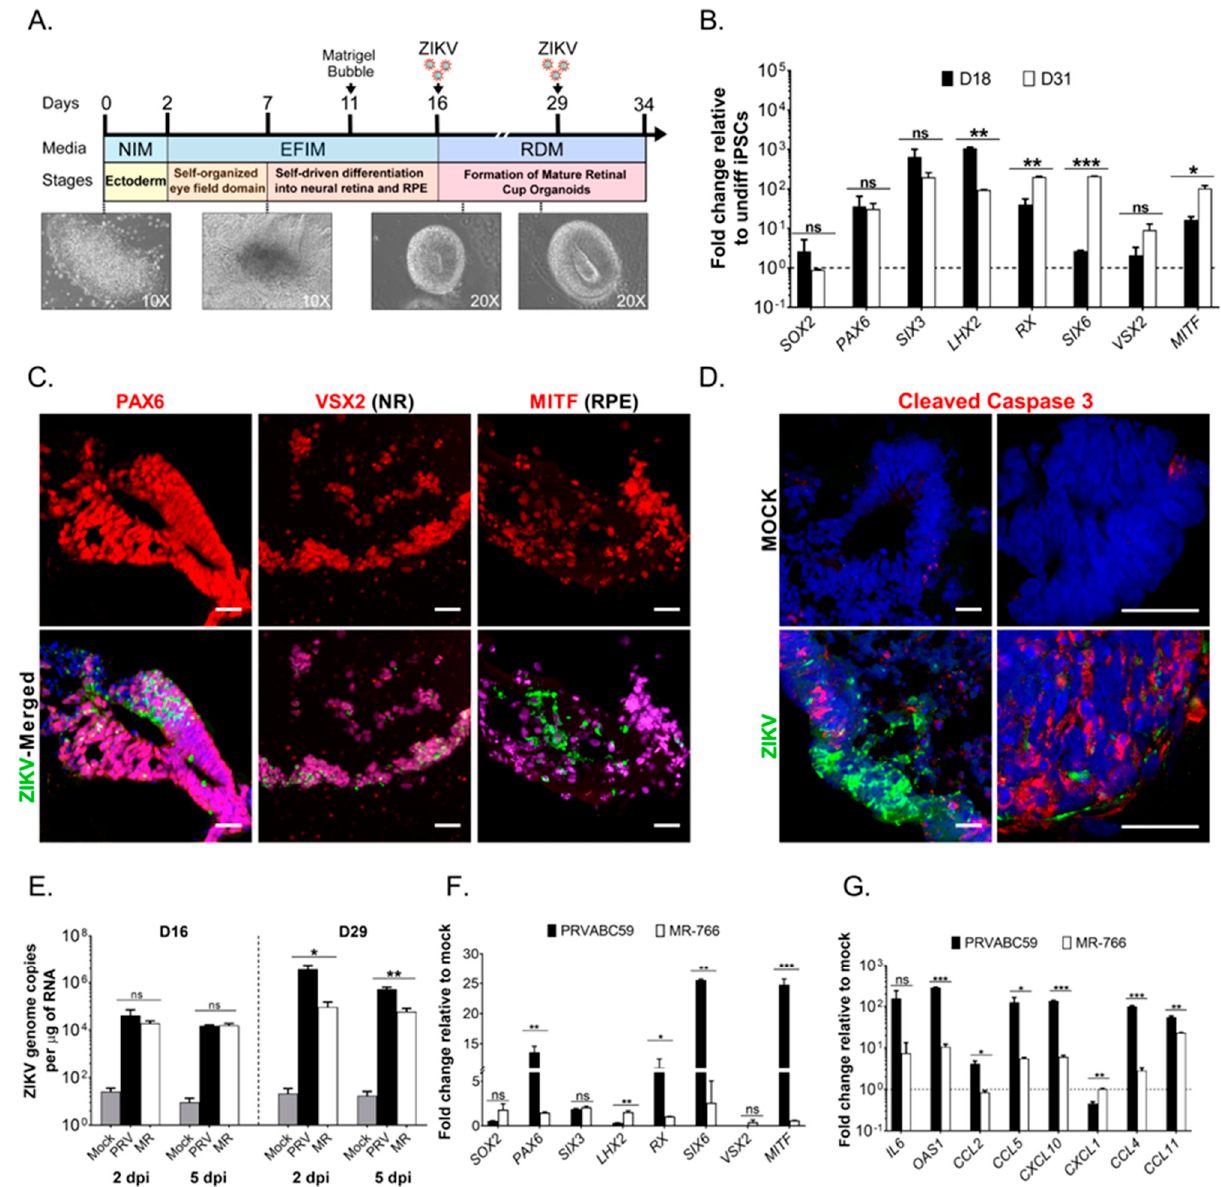
Figure 6. ZIKV infects the neural retina and RPE of human iPSC-derived Retinal Organoids. ( A ) Schematic timeline showing key differentiation stages of retinal organoids with stage-specific bright-field images. Organoids were infected with ZIKV on days 16 or 29 post-differentiation. ( B ) RT-qPCR analysis of early eye- and retinal-specific markers. Graph shows the fold change of each transcription factor relative to undifferentiated hiPSCs at days 18 and 31 post-differentiation. ( C ) Immunofluorescence images of mature retinal organoids infected on day 29 post-differentiation with ZIKV PRVABC59. Images show that PAX6, MITF (RPE), and VSX2 (neural retina, NR) positive cells (red) are infected with ZIKV (green) at 5 days post-infection (dpi). ( D ) Cleaved Caspase-3 (red) positive cells in mock and ZIKV-infected organoids at 5 dpi. Left panels (20X) and right panels (100X). Scale Bar: 25 µm. ( E ) Replication kinetics of ZIKV PRVABC59 and MR-766 of infected retinal organoids (day 16 and day 29 post-differentiation) at 2 and 5 dpi. Two-way ANOVA followed by Bonferroni test was performed. ( F ) RT-qPCR analysis of differentially expressed retinal markers in retinal organoids (day 16) after PRVABC59 and MR-766 infection (5 dpi). The fold change to uninfected (mock) organoids is shown. ( G ) Fold change in the expression levels of IL6, OAS1, and various chemokines at 5 dpi. Students t-test, where p -value <0.05 (*), p < 0.001 (**), and p < 0.0001 (***), and ns, no significance. Data are representative of three-independent experiments.